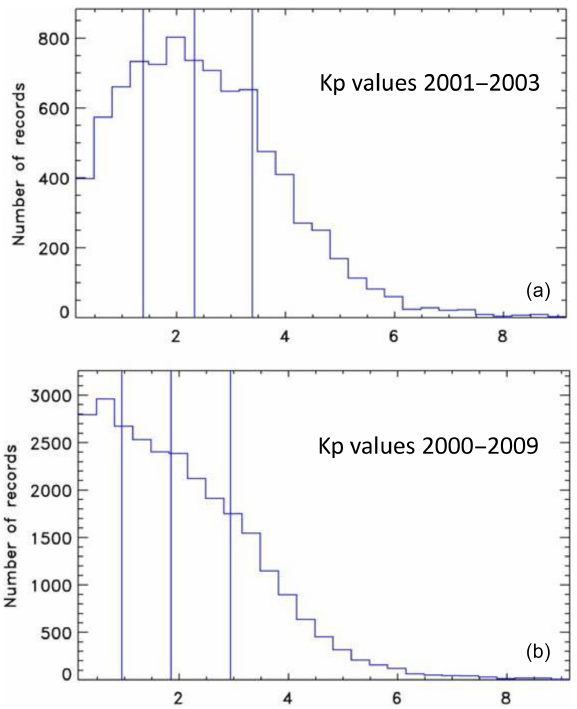
Figure 13. Frequency distribution of Kp values. (a) From 2001 to 2003 representing solar maximum. (b) From 2000 to 2009 covering most of the period of the CHAMP